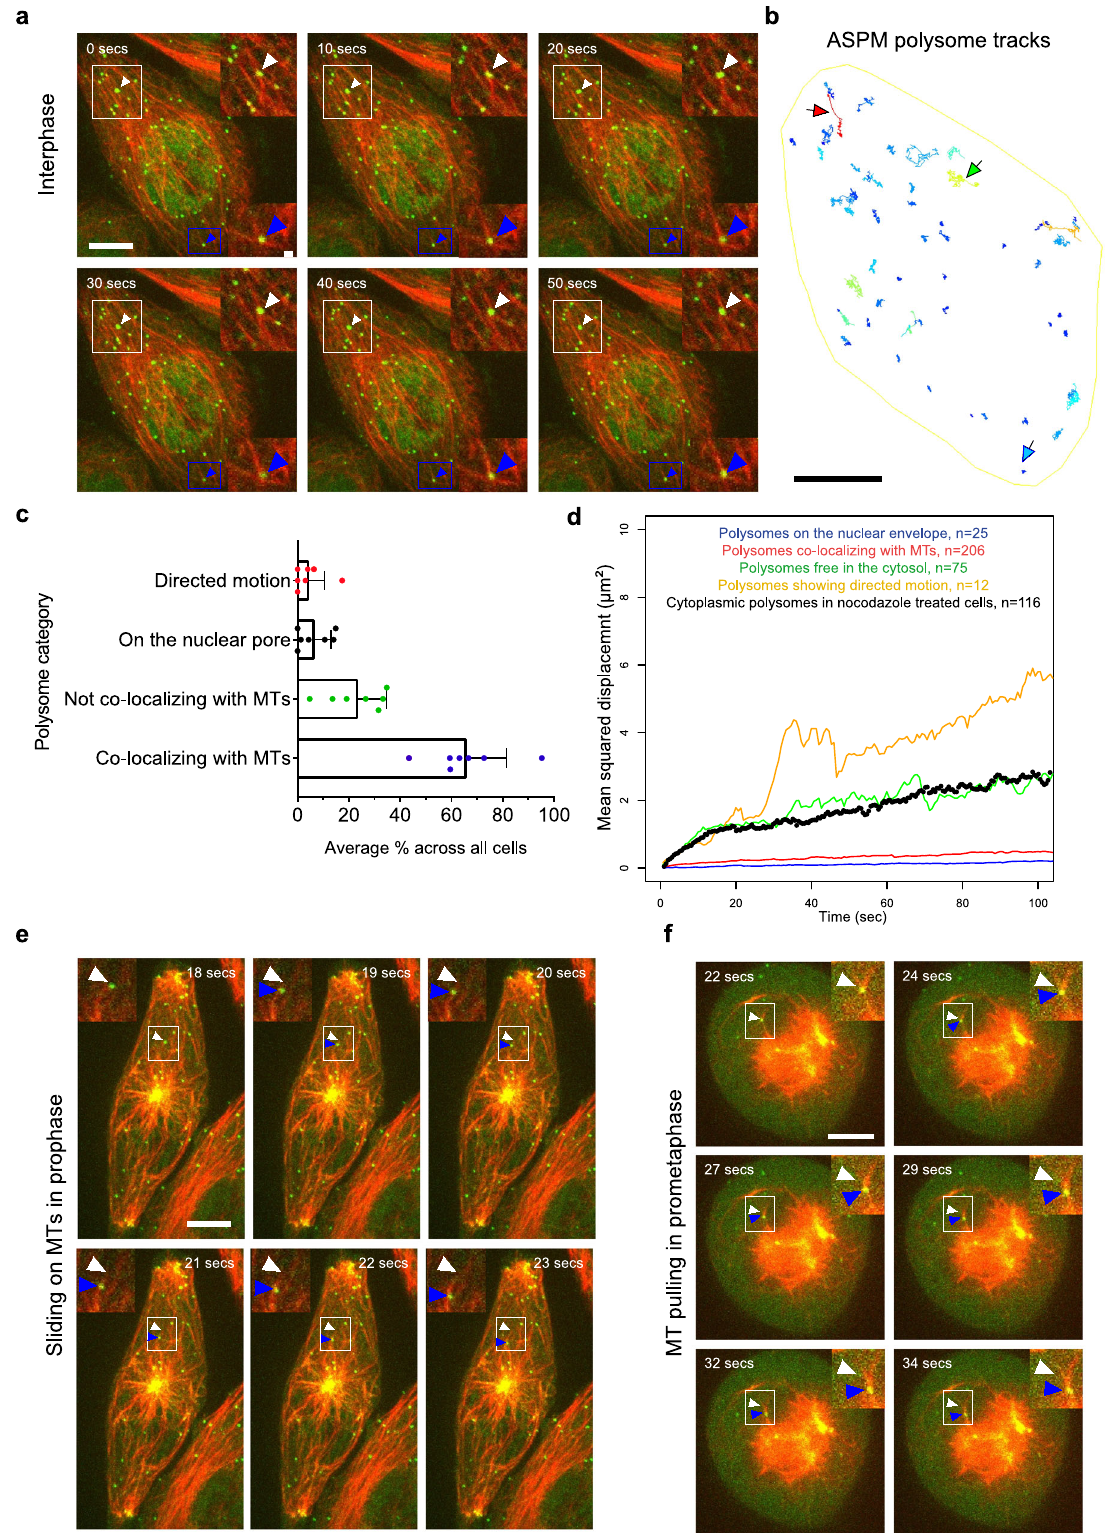
underlies conserved features in mRNA localization mechanism and/or function. A cell cycle-dependent translational program operates at cen- trosomes . Our data reveal that centrosomal mRNA